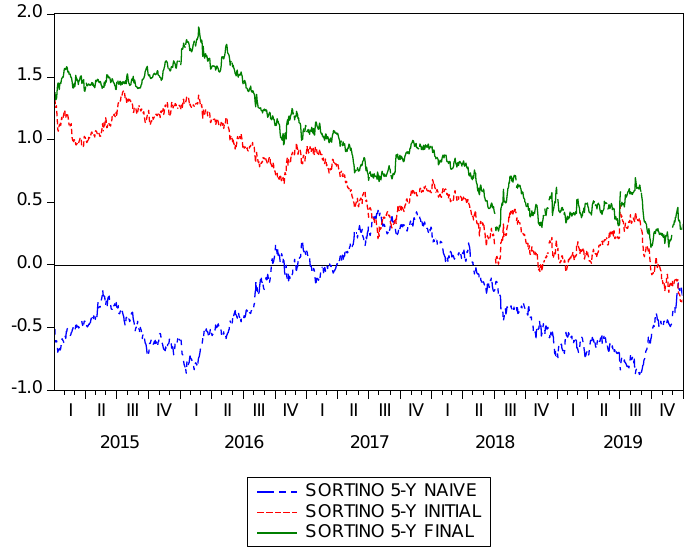
Figure 5. Sortino ratios of strategies (5-year rolling window). This figure displays the 5-year rolling window Sortino ratios over the out-of-sample period for the naïve strategy, the best strategy using logarithm returns, labeled as initial, and the best one using standardized returns, labeled as final. Finally, some data snooping tests (Reality Check and Superior Predictive Ability) are carried out to test the null hypothesis that the better performance of the proposed strategies compared to the rest is just based on luck. Table 9 shows the p -values from the Reality Check test and the lower, centered, and upper p -values from the Superior Predictive Ability (SPA) test, but also their nominal p